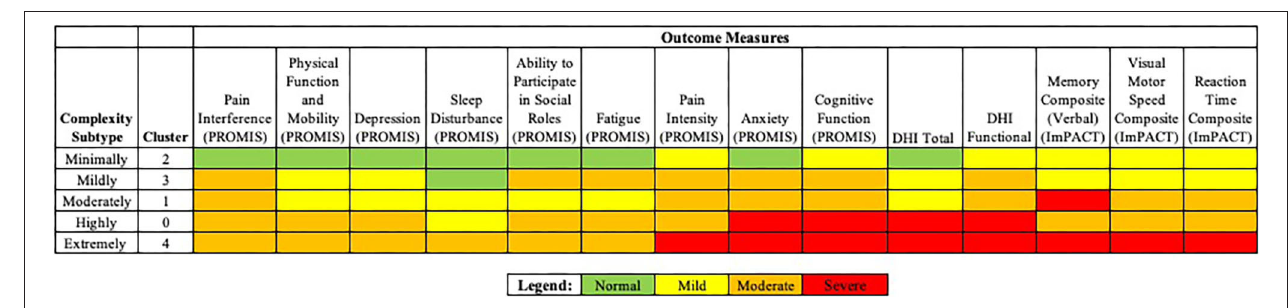
FIGURE 4 | Concussion subtypes (clusters) according to